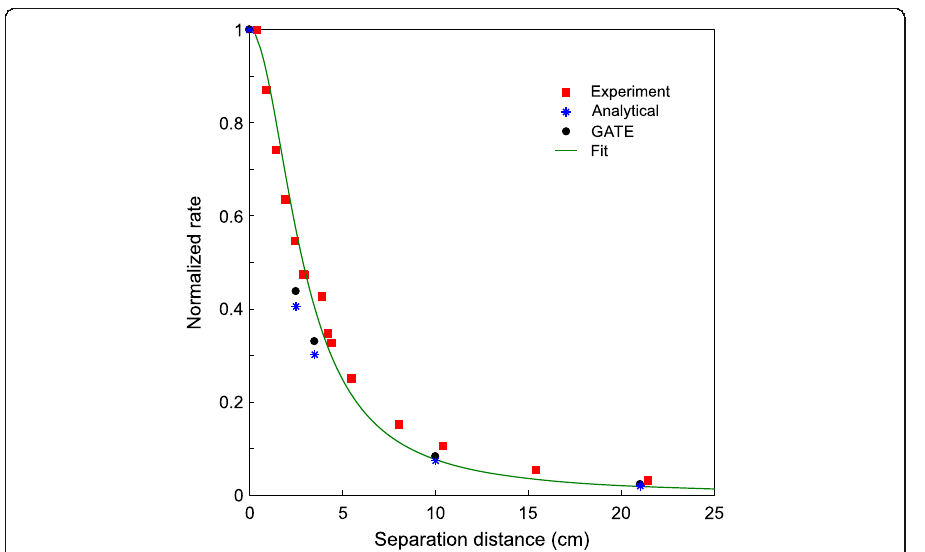
Fig. 8 Normalized count rate for two opposing LYSO scintillation crystals of dimensions 57.4 × 57.4 × 10 mm 3 as a function of d . Note that for the experimental count rate more separation distances were included for completeness. Experimental uncertainties for the detector separation distance are smaller than the symbol